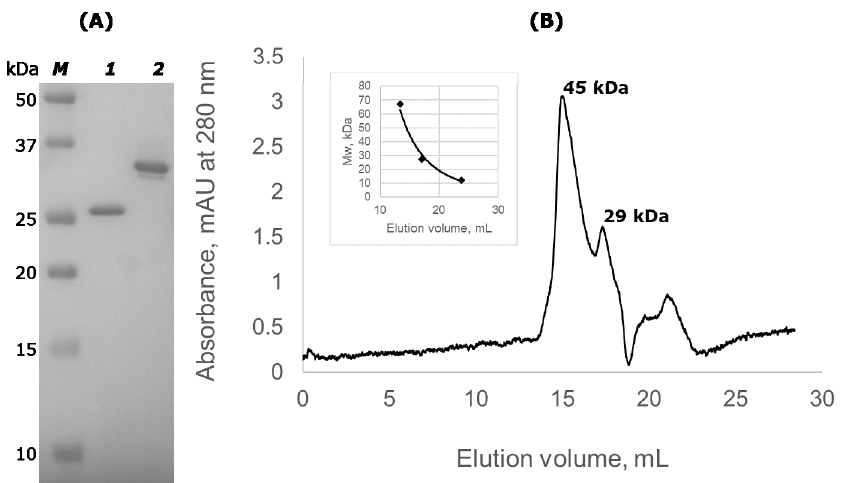
Figure 2. SDS-PAGE and size exclusion chromatography (SEC) of Lst-HDD. ( A ) SDS-PAGE of purified lysostaphin (lane 1) and Lst-HDD (lane 2); lane M contains molecular weight standards with their molecular weights indicated on the left ( B ) SEC chromatogram of Lst-HDD. The inlet shows the molecular weight calibration of the column.